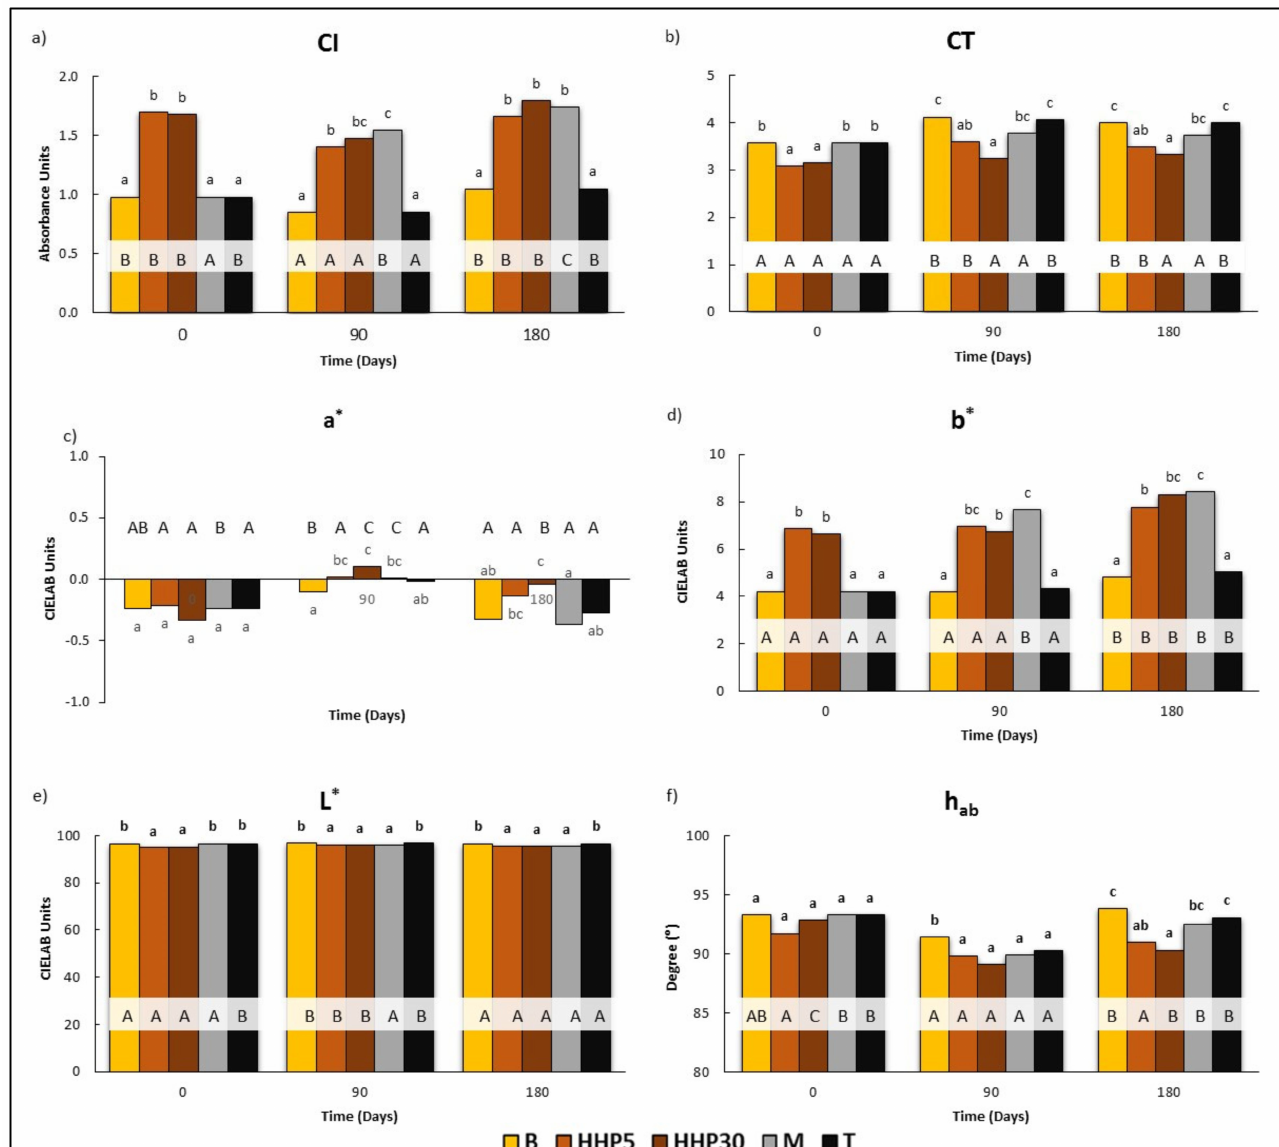
Figure 3. Effect of the application of HHP and maceration with holm oak chips on the evolution of chromatic character- istics in Cayetana wine: ( a ) Color intensity (CI), Absorbance Units; ( b ) Tint (CT); ( c ) Red − greenness (a*), CIELAB units; ( d ) Yellow − blueness (b*) CIELAB units; ( e ) Lightness (L*), CIELAB units; ( f ) Hue angle (h ab ), degree ( ◦ ). B: Wines bottled without any treatment; HHP5, HHP30: Wines bottled after maceration of holm oak chips (5 g/L) with HHP treatments (400 MPa, 5 and 30 min). M and T: Wines bottled after storage for 45 days in tanks with and without maceration of holm oak chips (5 g/L). Different lower case letters indicate a significant difference ( p < 0.05) among the treatments for the same day. Different capital letters indicate a significant difference ( p < 0.05), for the same treatment on different